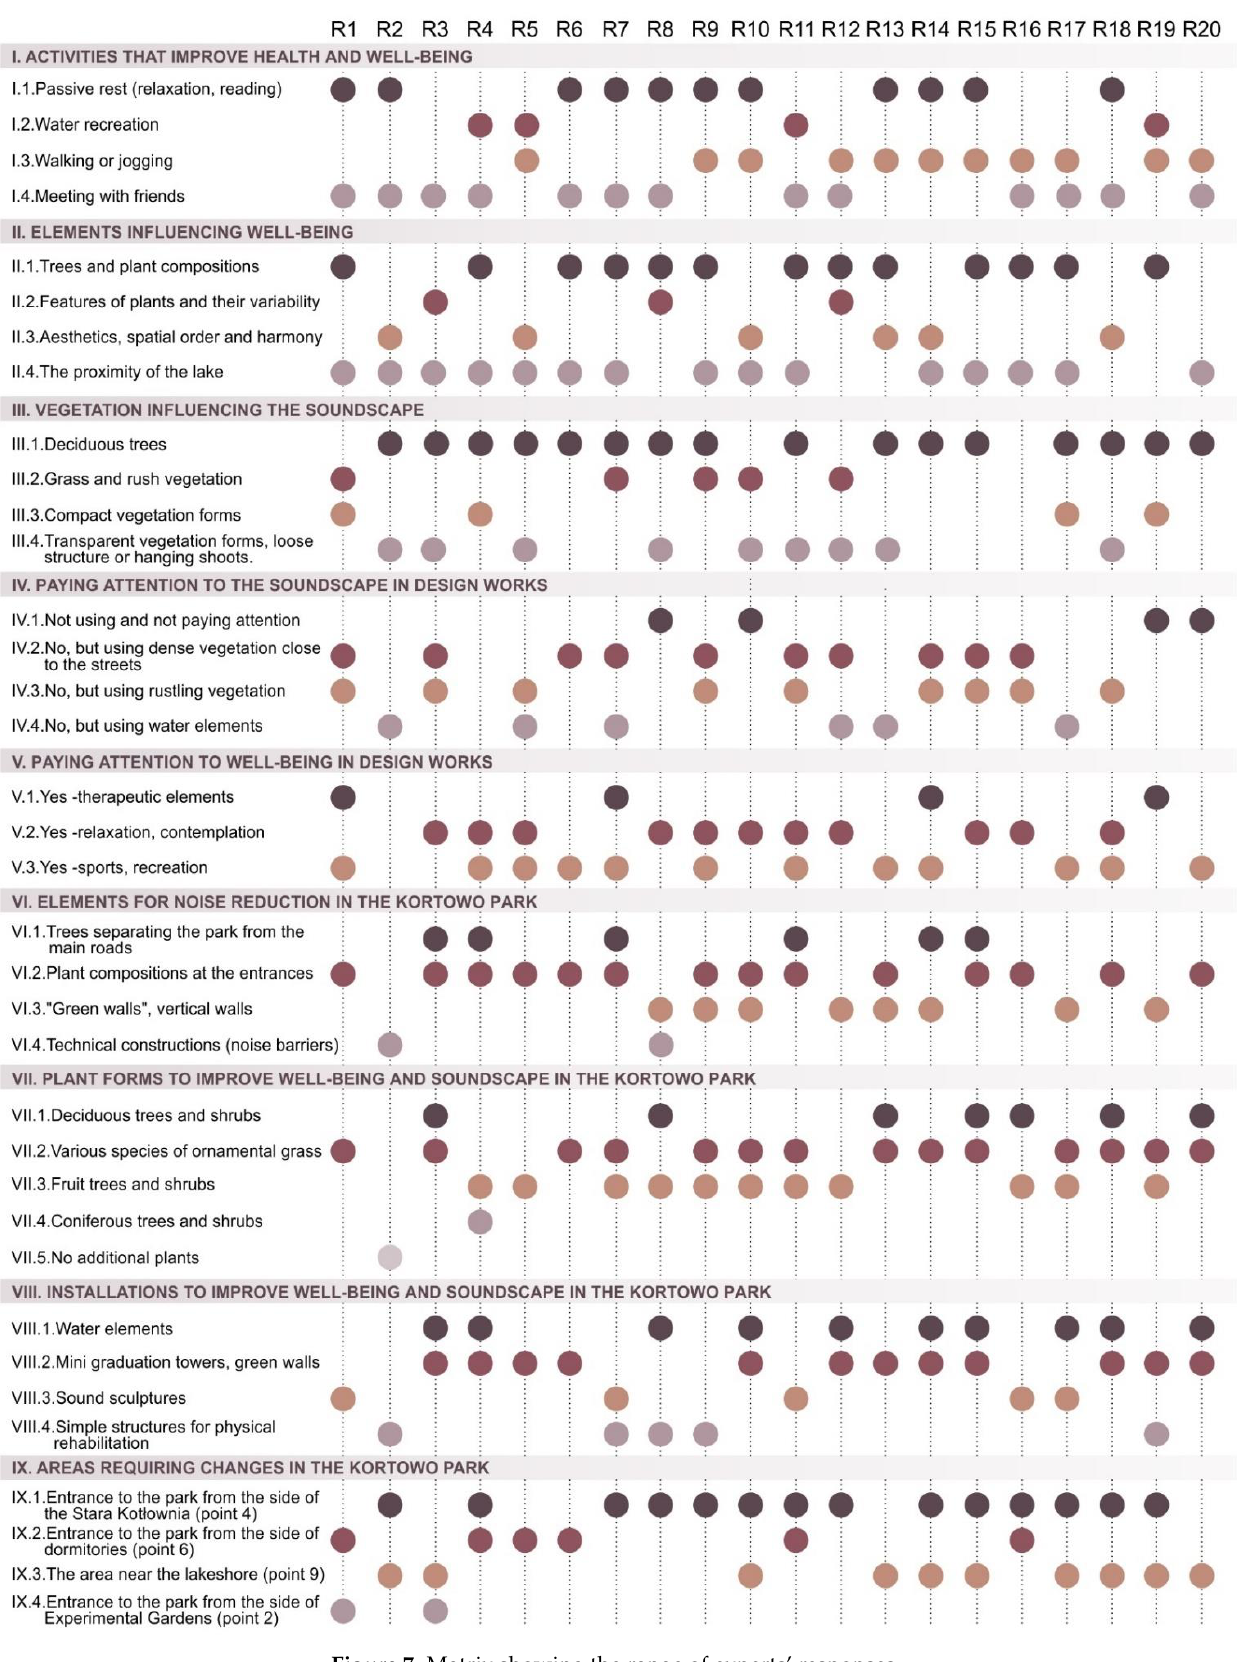
Figure 7. Matrix showing the range of experts’ responses.